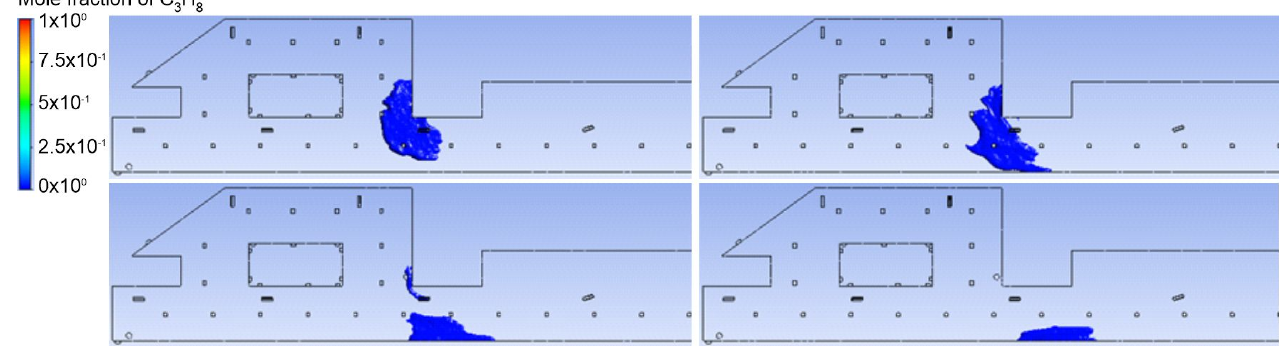
Figure 7. Lower explosive limit of LPG distribution in an underground garage after gas dispersion for A source for different time steps: 15 s, 35 s, 55 s and 70 s.